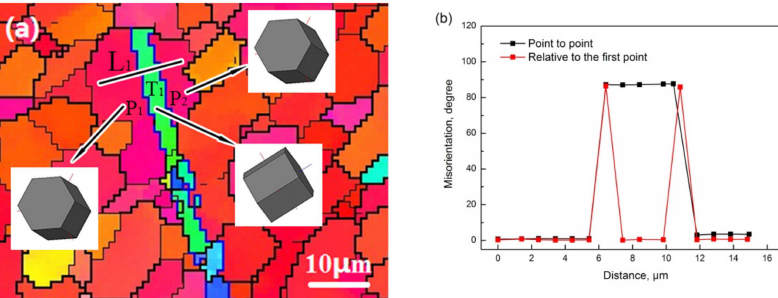
Figure 12. The EBSD analysis of FSW joint after base bending to 5% ( a ) crystallographic orientation map and ( b ) misorientation distribution along the lines L 1